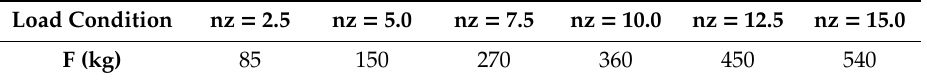
Table 3. Load conditions used in Stage 3—parachute